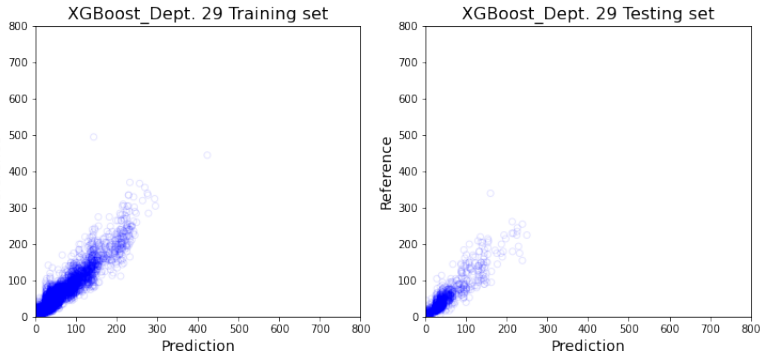
Figure A13. Model Performance of XGBoost on Dept.29. The visualization of training and testing data for department specific model on department 29 with XGBoost.